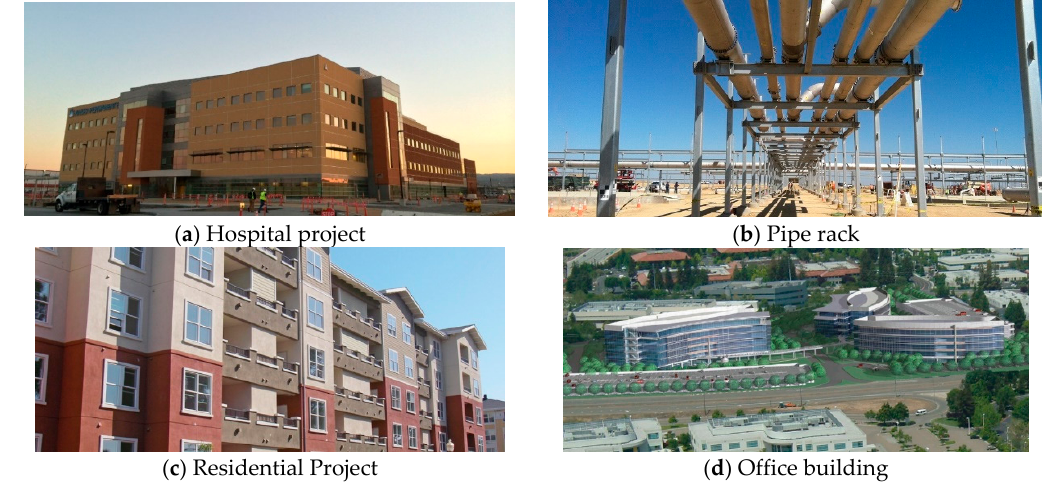
Figure 4. Examples of projects using ConXtech structural steel (Source: ConXtech, used with permission from Kelly Luttrell).